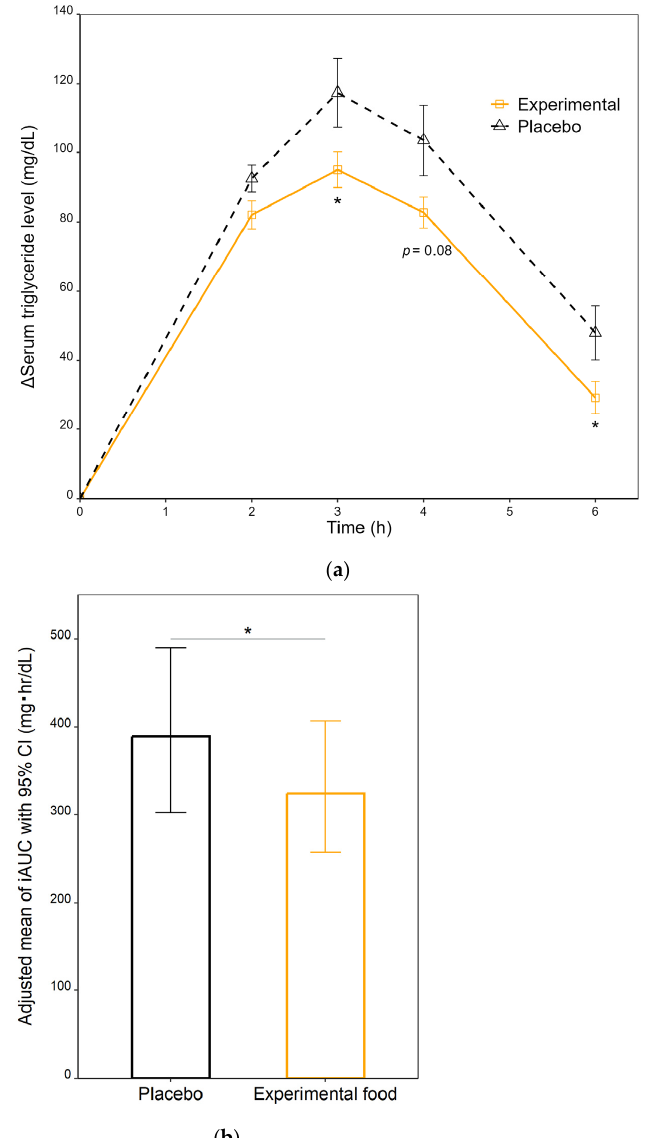
Figure 3. Postprandial triglyceride (TG) responses to ingestion of the experimental food or placebo and the standardized high-fat diet. ( a ) Time course of the incremental postprandial serum TG concentrations. Values are mean ± standard error (SE). Statistical analysis by two-tailed, paired t -tests. * p -value < 0.05. ( b ) Incremental area under the curve (iAUC) of postprandial serum TGs. Values are covariate-adjusted mean ± 95% confidence interval (CI) and were compared by using a mixed-effects model with intervention, gender, age, body mass index (BMI) and sequence as fixed variables and subject as a random effect. * p -value <